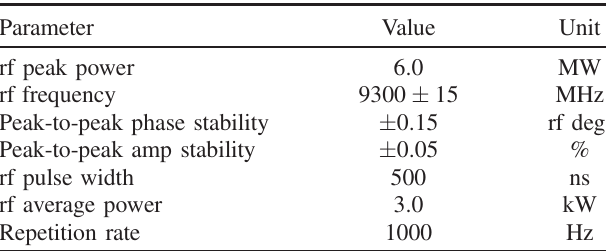
TABLE VII. Klystron modulator basic specifications. Weight includes klystron, focus coil, and focus coil power